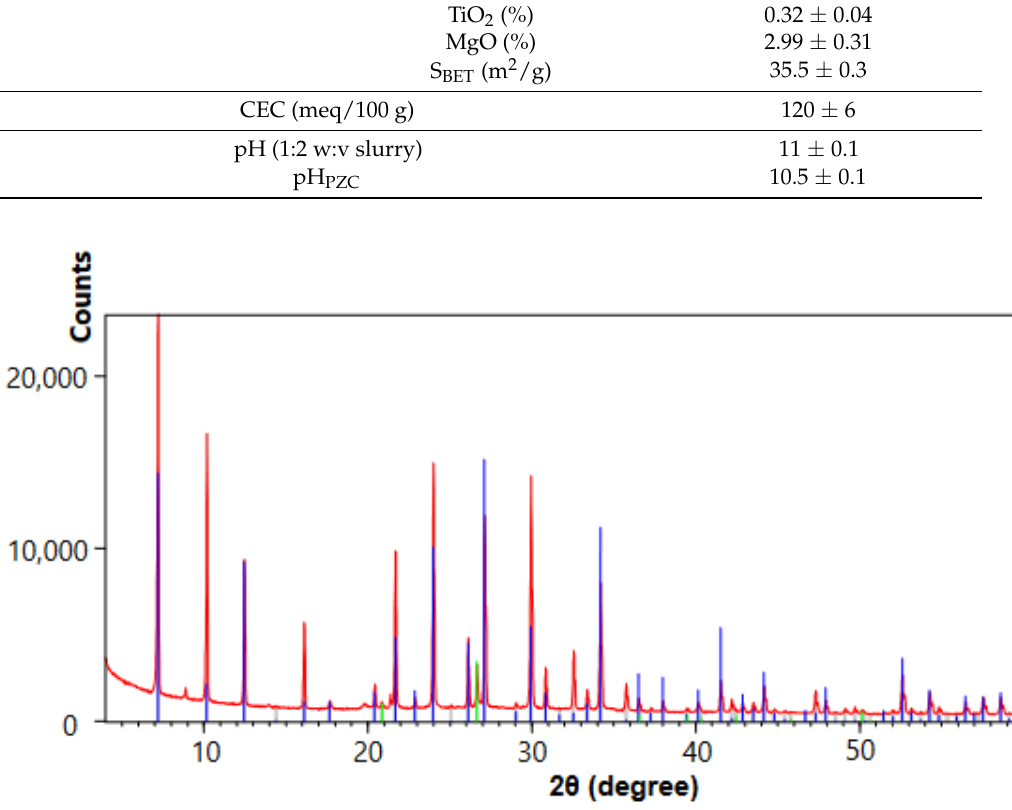
Figure 1. XRD pattern of 4AZW. Table 1. Physicochemical properties of 4AZW.